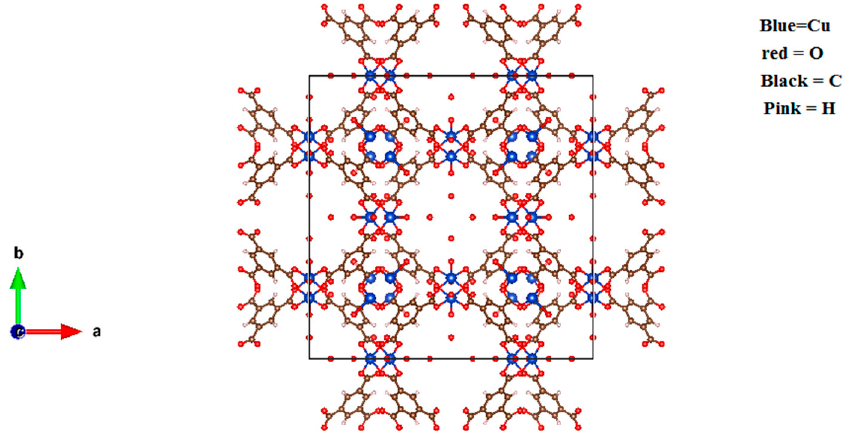
Figure 3. Structure of HKUST-1.